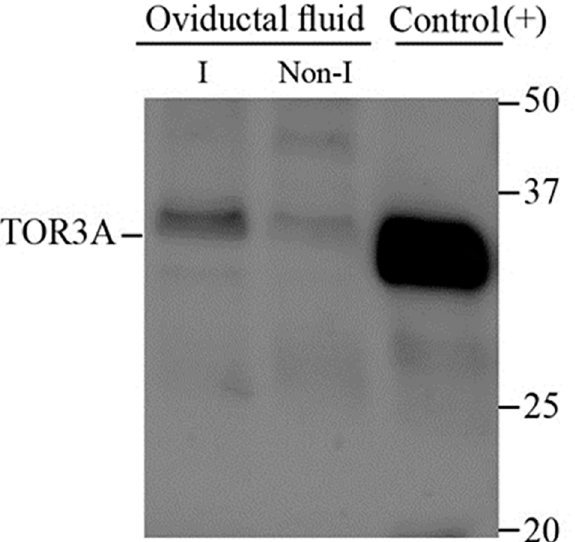
Fig 8. Western-blotting detection of TOR3A in porcine oviductal fluid. Expression of the TOR3A increases in the oviductal fluid of the inseminated sows (I) (Lane 1) compared to non-inseminated animals (Non-I) (Lane 2). Protein TOR3A (RPG629Hu01, Uscn Life Sciences, Wuhan, China) was used as a positive control (Lane 3). Molecular weight is expressed in kDa.